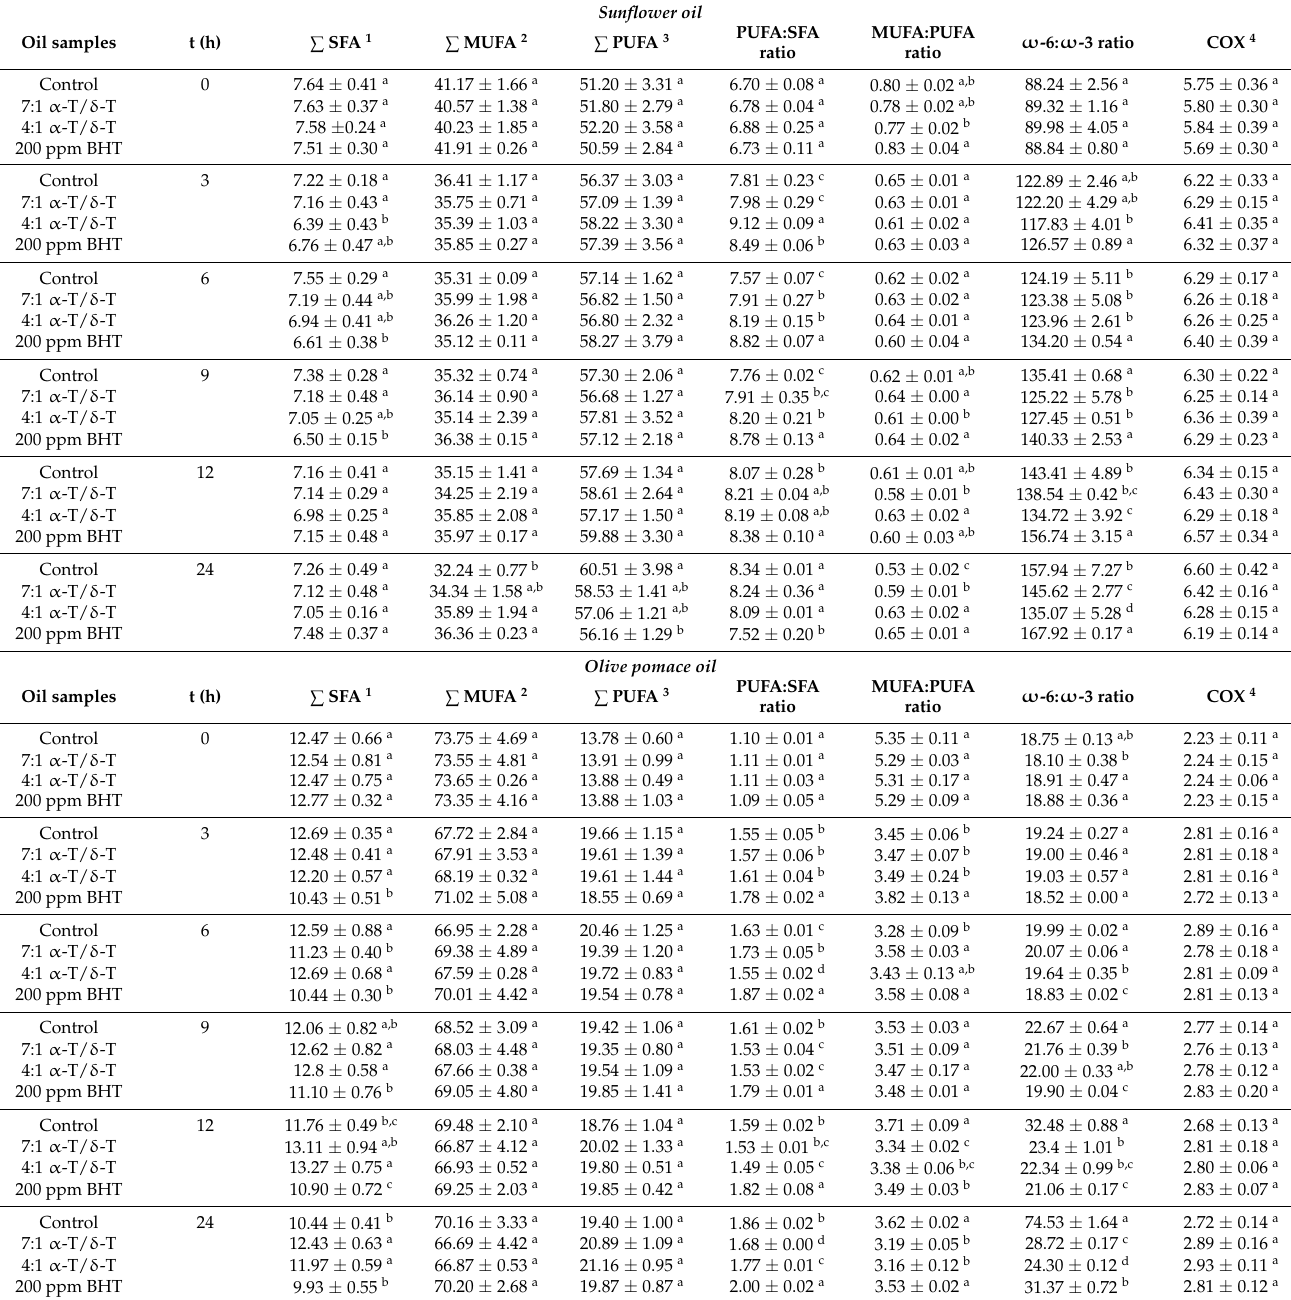
Table 4. Changes in the percentages of fatty acids in samples of sunflower oil and olive pomace oil during Rancimat incubation time (h). Inside columns with a specific superscript letter (e.g., a–d) indicate a significant ( p < 0.05) difference for each Rancimat incubation